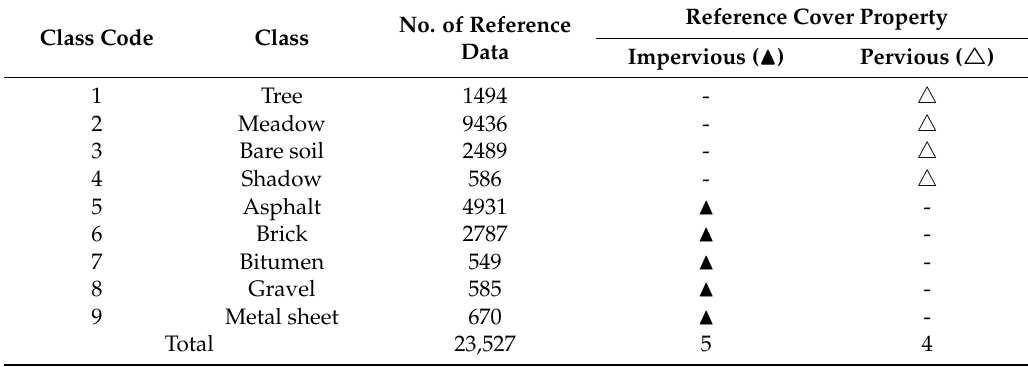
Table 2. The dataset display of land-cover classes and reference data in the university scene of the Pavia,